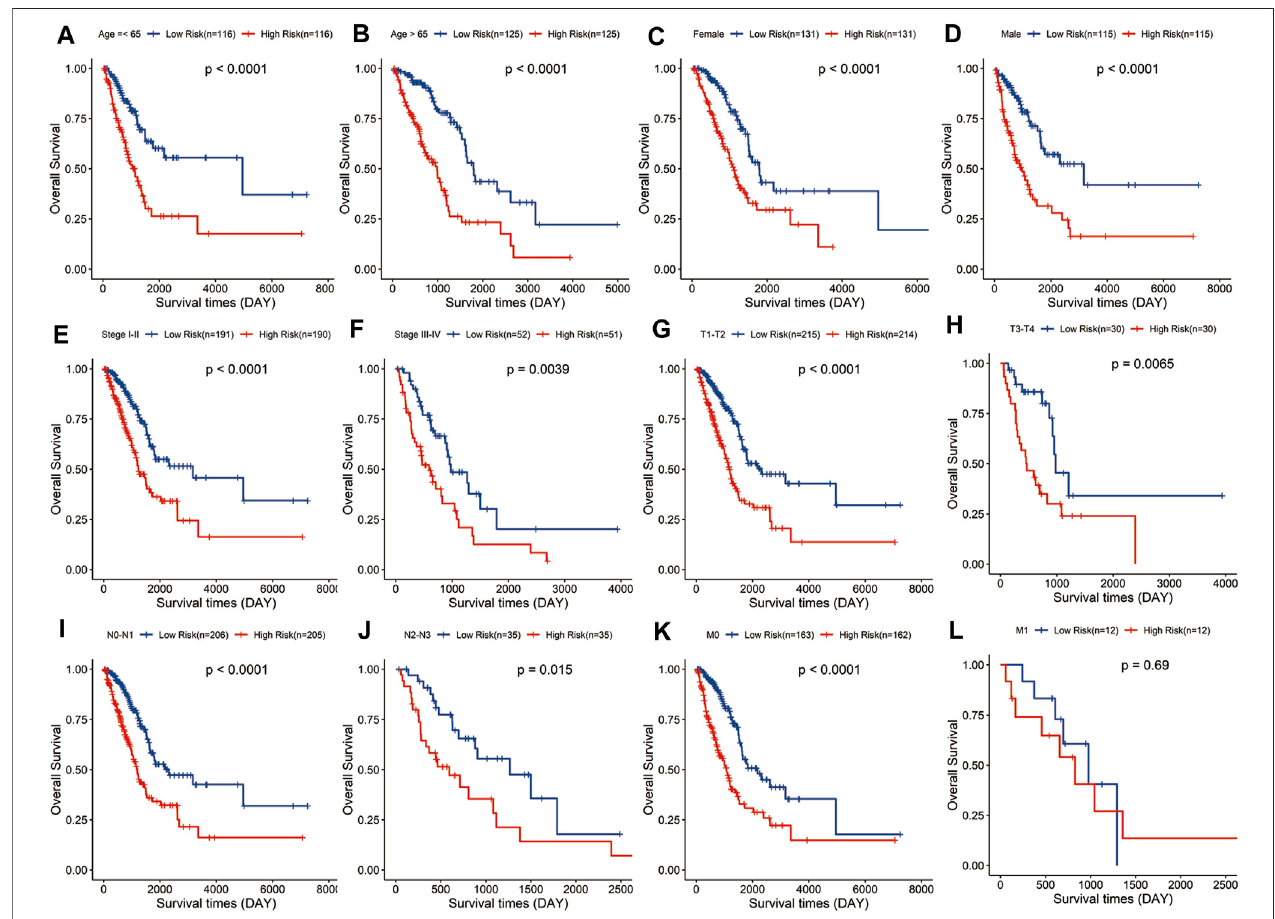
FIGURE 4 | Evaluation of the signature in different subgroups of LUAD patients. Survival analysis in low- and high-risk groups adjusted by clinical variables, including age (A,B) , gender (C,D) , tumor stage (E,F) , and TNM stage (G – L)